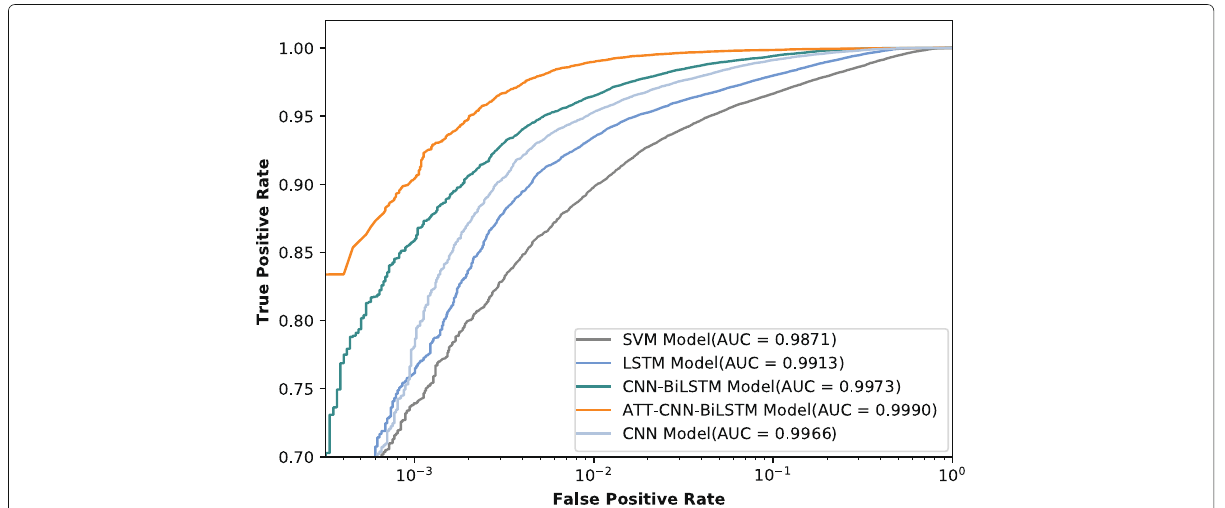
Fig. 2 ROC curve on the detection of DGA domain names. The x-axis indicates the false positive rate while the y-axis shows the true positive rate